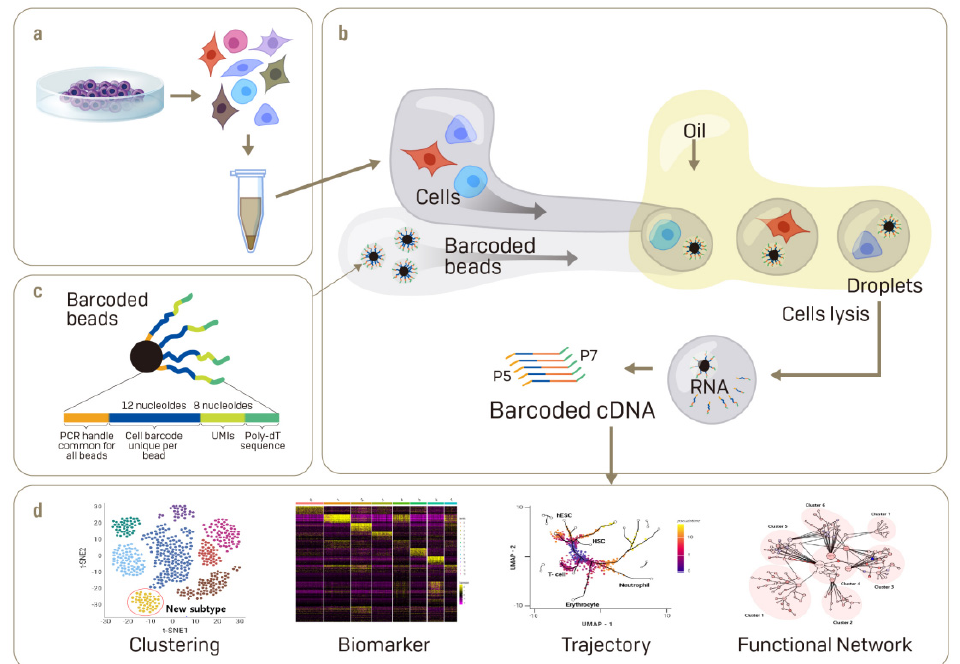
Figure 1. Generation of single-cell transcriptomic data using microfluidic technology. Overview of the workflow for single-cell transcriptomic analysis using microfluidics. ( a ) Cultured stem cells are initially dissociated enzymatically to generating live single cells. ( b ) Overview of the droplet-based microfluidic system. Individual cells are encapsulated in an oil droplet with a barcoded bead and captured cells are lysed within the droplets. ( c ) Microbeads coated with DNA probes that comprise a PCR handle, cell barcode, unique molecular identifiers, and poly-dT sequence. ( d ) Sequencing of cDNA yields the library of transcriptomes from individual cells, counted as unique reads per gene, and analyzed/visualized.